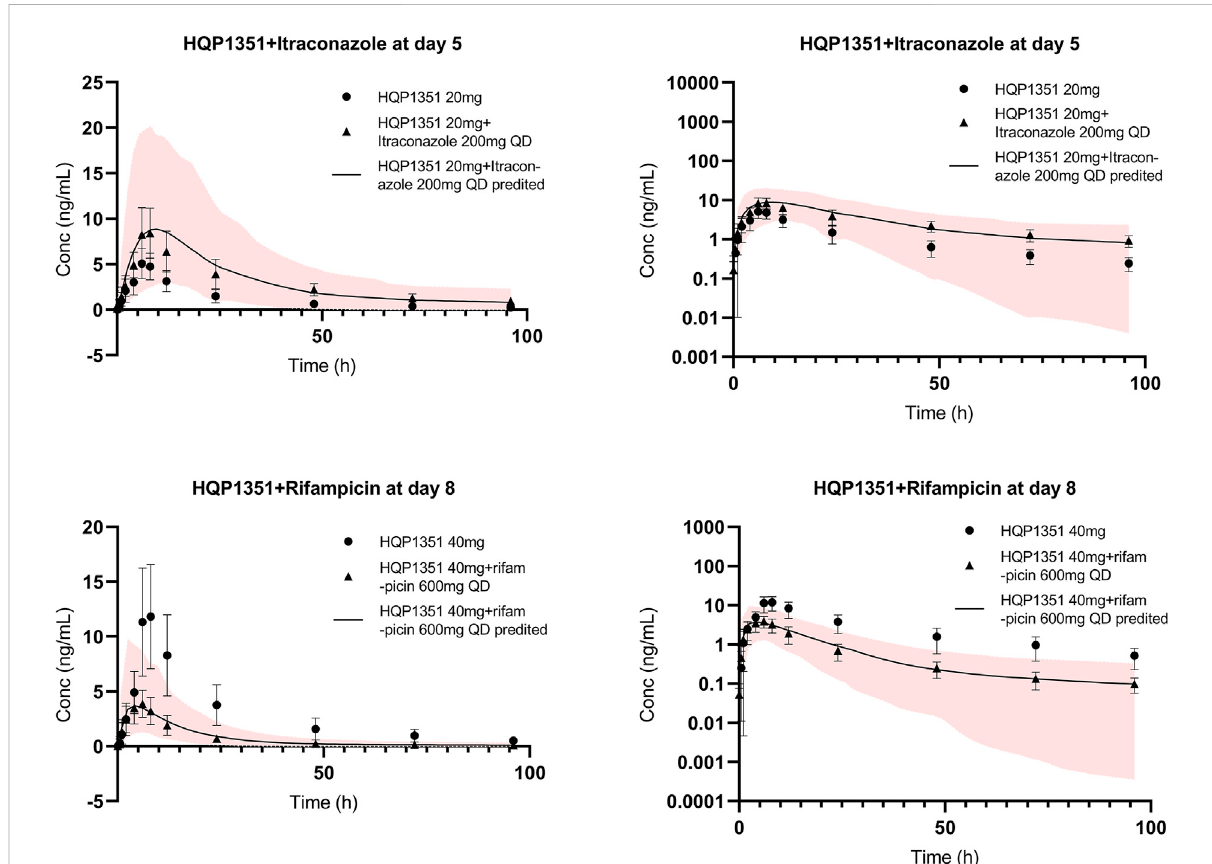
FIGURE 3 Further veri fi cation of olverembatinib PBPK model. Observed (mean and standard deviation, dots for single dose, triangle for coadministration and bar) and simulated (solid lines for coadministration) mean plasma concentration-time pro fi les of olverembatinib in healthy American volunteers following oral doses of olverembatinib (left panels = linear scale; right panels = semi-log scale). The shaded area is the 5% – 95% range in concentrations from 1,000 simulated healthy American adult